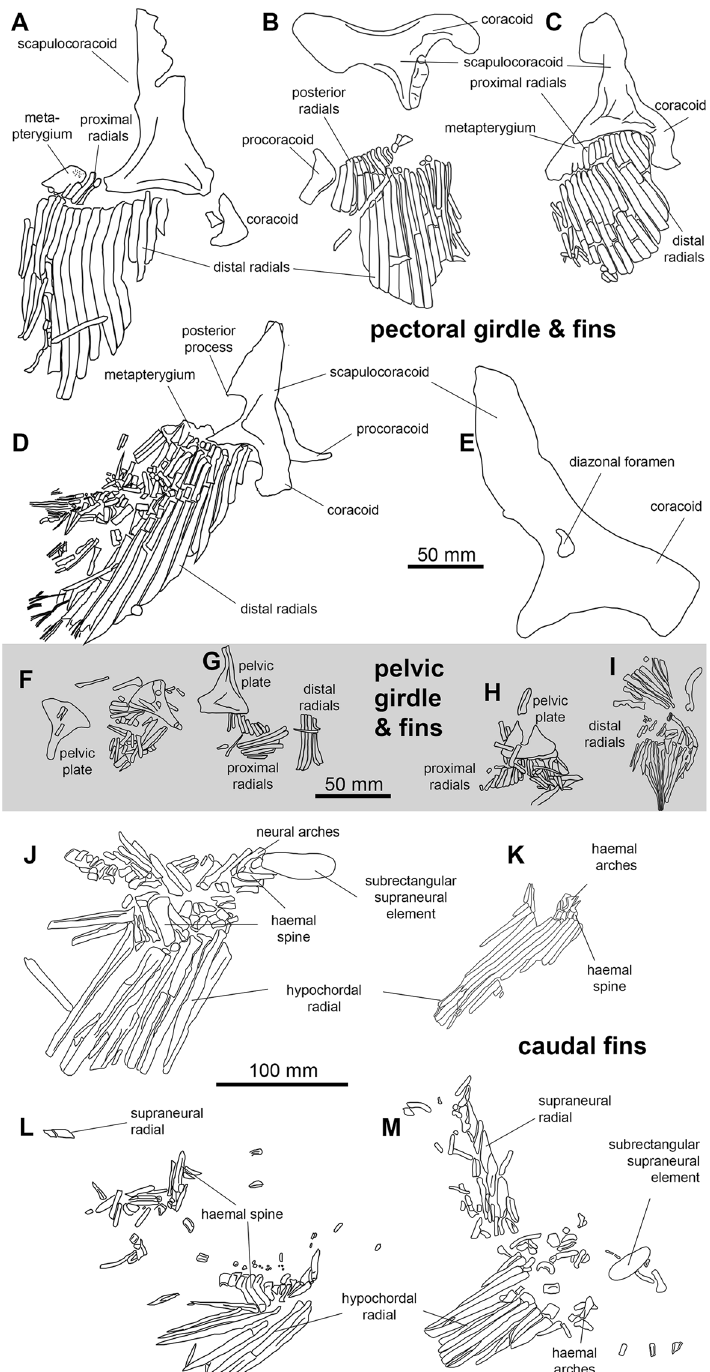
Fig. 8 Fins of Maghriboselache mohamezanei n. gen. et sp. A left pectoral fin of the holotype AA.MEM.DS.12. B, C right and left pectoral girdle elements and pectoral fins of PIMUZ A/I 5155; D left pectoral girdle elements and left pectoral fin of PIMUZ A/I 5156, E left scapulocoracoid of PIMUZ A/I 5152. F to I Pelvic girdle and pelvic fins. F PIMUZ A/I 5156, G PIMUZ A/I 5163, H PIMUZ A/I 5155, I PIMUZ A/I 5153. J to M Caudal fins. J AA.MEM.DS.12, K isolated fin, PIMUZ A/I 5163, L PIMUZ A/I 5153, M AA.BER.DS.01. Photos of the fins are in Fig. 1 and in Additional file 1: Fig. S5 to S11, S13, S14, S16 to S18, S20 to S25, S27,